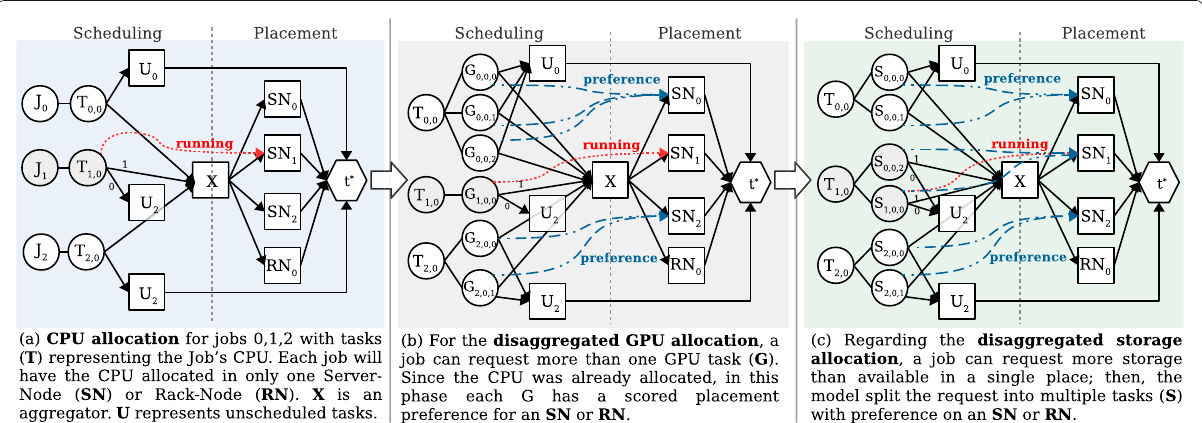
Fig. 2 Proposed flow network modeling. All disaggregated resources are allocated incrementally in different phases. Each phase depends on the previous one and are optional depending which resource can be disaggregated. Additionally, each phase determines the jobs’ placement preferences that directly changes the arc costs to machines accordingly with the applied policy